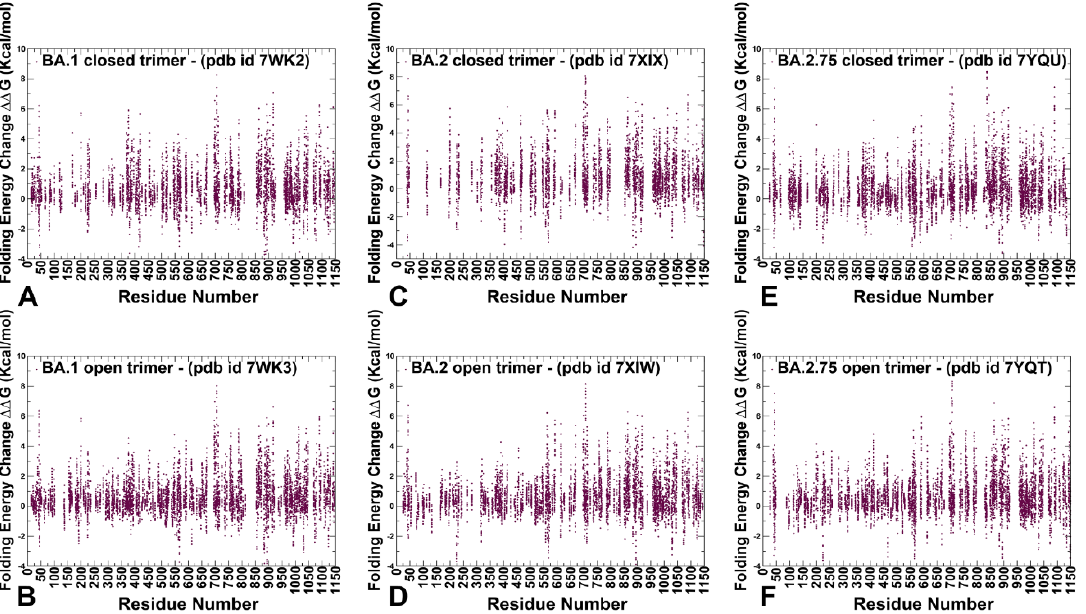
Figure 6. Ensemble-based mutational scanning of protein stability and binding for the SARS-CoV- 2 S Omicron trimers. The mutational scanning scatter plot for the SARS-CoV-2 Omicron BA.1 closed trimer, pdb id 7WK2 ( A ). S Omicron BA.1 trimer in the open form, pdb id 7WK3 ( B ). S Omicron BA.2 closed trimer, pdb id 7XIX ( C ). S Omicron BA.2 trimer in the open form, pdb id 7XIW ( D ). S Omicron BA.2.75 closed trimer, pdb id 7YQU ( E ). S Omicron BA.2.75 trimer in the open form, pdb id 7YQT ( F